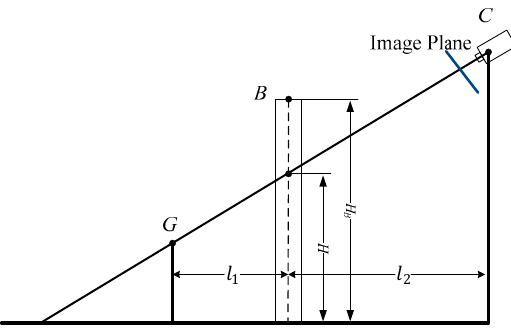
B Figure 2. Camera model. A point G is visible in an image if and only if the sight line CG determined by camera C and point G crosses the image plane and there is no obstacle across the sight line CG . As shown in Figure 2, the point G 1 is visible, but the point G 2 is blocked by obstacle B . The profile is shown in Figure 3. ( X B , Y B , H B ) are the coordinates of B . The height H of the line of sight CG at the location of B is